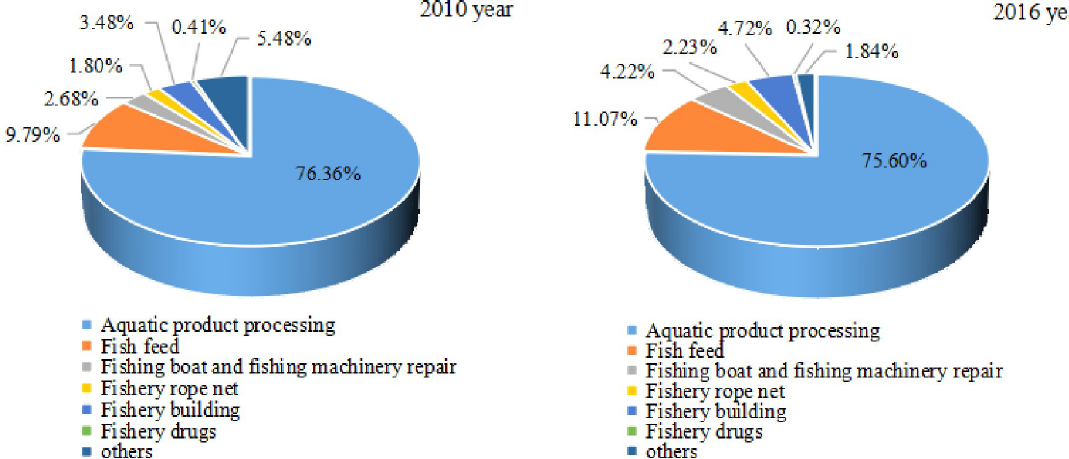
Fig 5. Industrial distribution in the secondary fishery industry (2010,